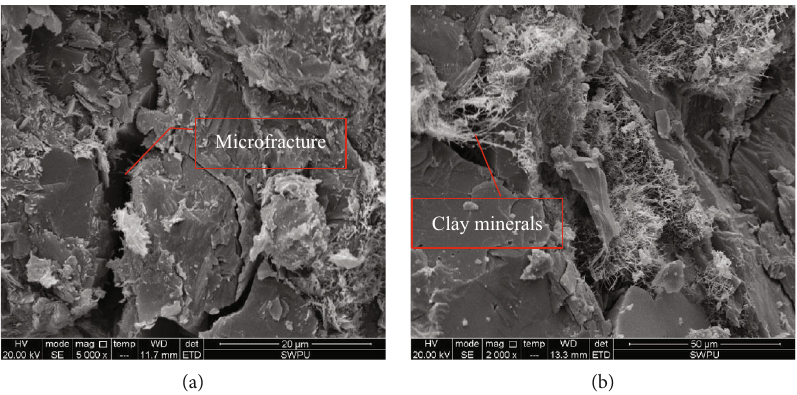
Figure 3: Examples of (a) microfractures and (b) clay minerals in shale